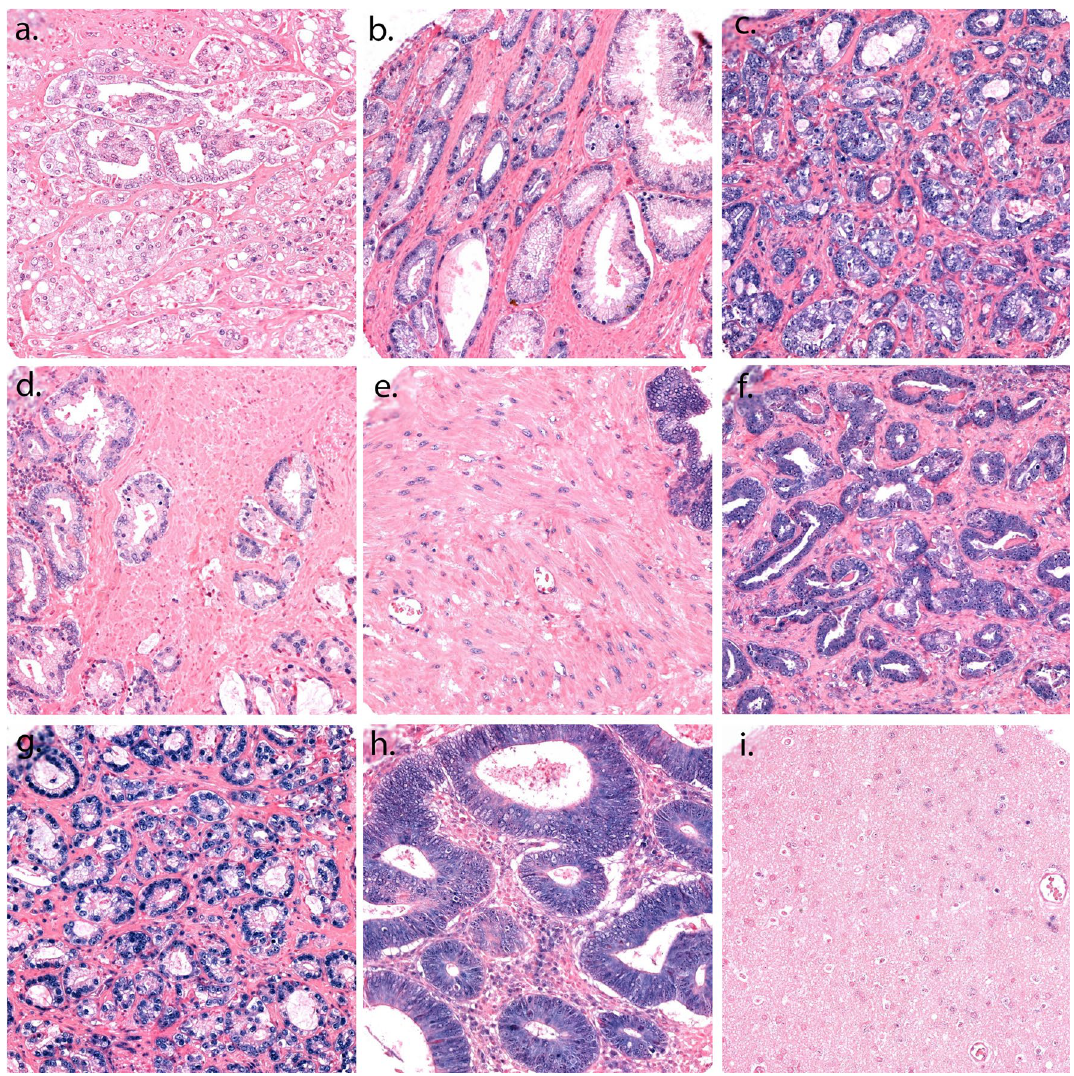
Figure 2. A panel of representative cores with scoring of tumor epithelium and tumor stroma for miR-17-5p stained by ISH. TE is scored by the intensity of the staining in the cell cytoplasm and core, with values from 0–3, and TS is scored by the density of positive cells in the examined core. ( a ) Score 1 in TE; ( b ) Score 2 in TE; ( c ) Score 3 in TE; ( d ) Score 1 in TS; ( e ) Score 2 in TS; ( f ) Score 3 in TS; ( g ) U6 control staining; ( h ) Positive tissue control: normal human colon tissue; ( i ) Negative tissue control: normal human brain tissue. Magnification